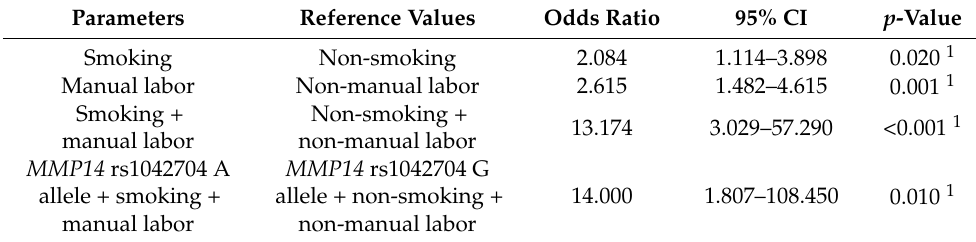
Table 7. The odds ratio for risk factors in Dupuytren’s